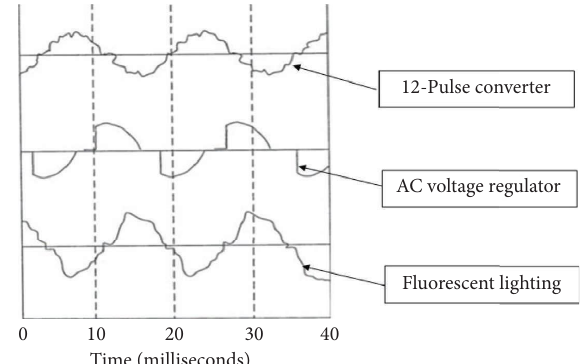
Figure 1: Te waveform of some disturbing